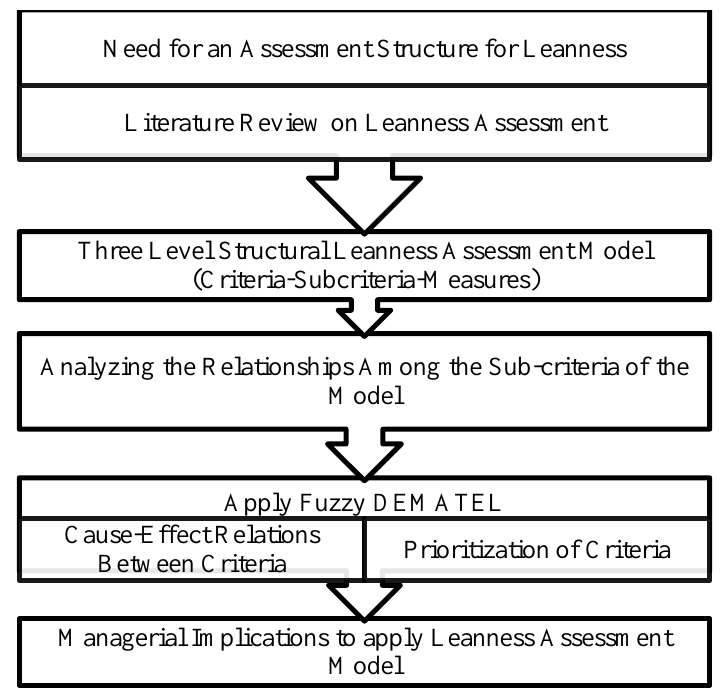
Figure 1. Structure of the